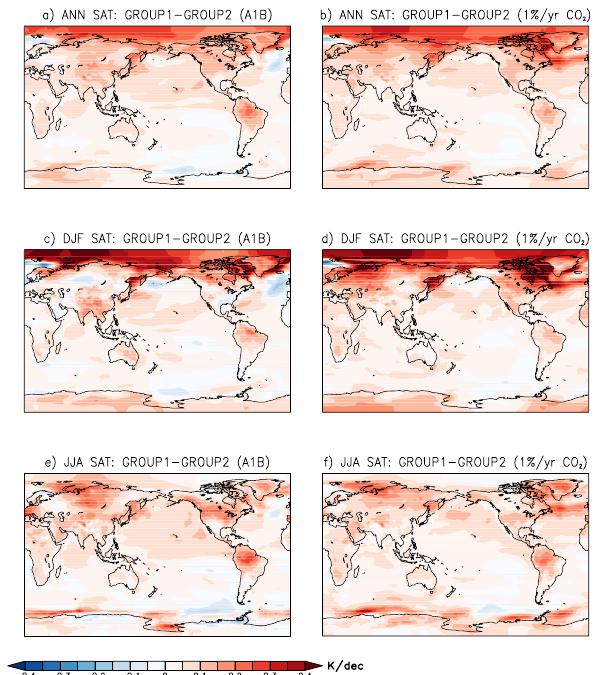
Fig. 1. Differences in annual mean (ANN), DJF and JJA surface air temperature (SAT) trends (in K per decade) between two groups of CMIP3 climate models. Trend differences for 2001–2050 in the A1B experiment are shown on the left, while differences for years 1–70 in the 1%yr − 1 CO 2 experiment are on the right. Models in GROUP1 included stratospheric ozone recovery in the A1B exper- iment and GROUP2 models did